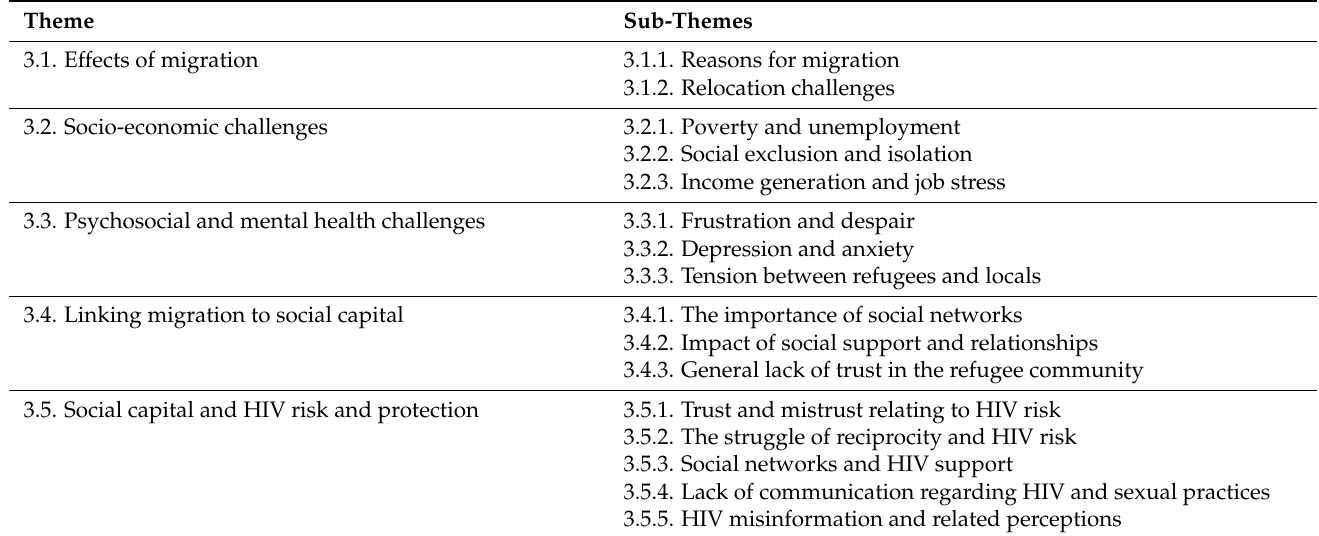
Table 2. Summary of themes and